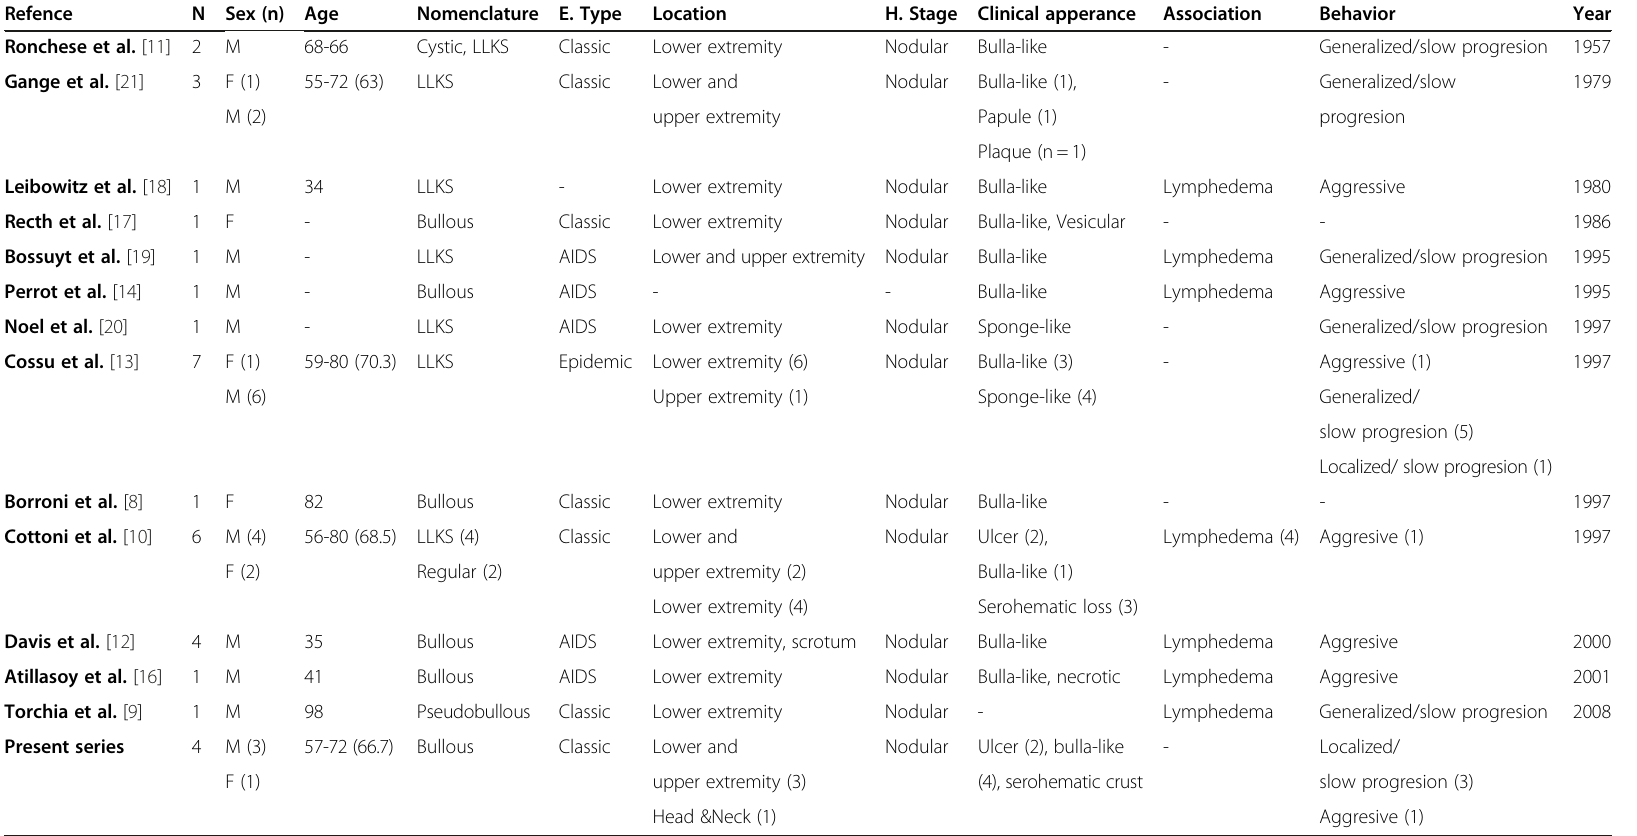
Table 3 Bullous Kaposi sarcoma: Review of the English-language literature